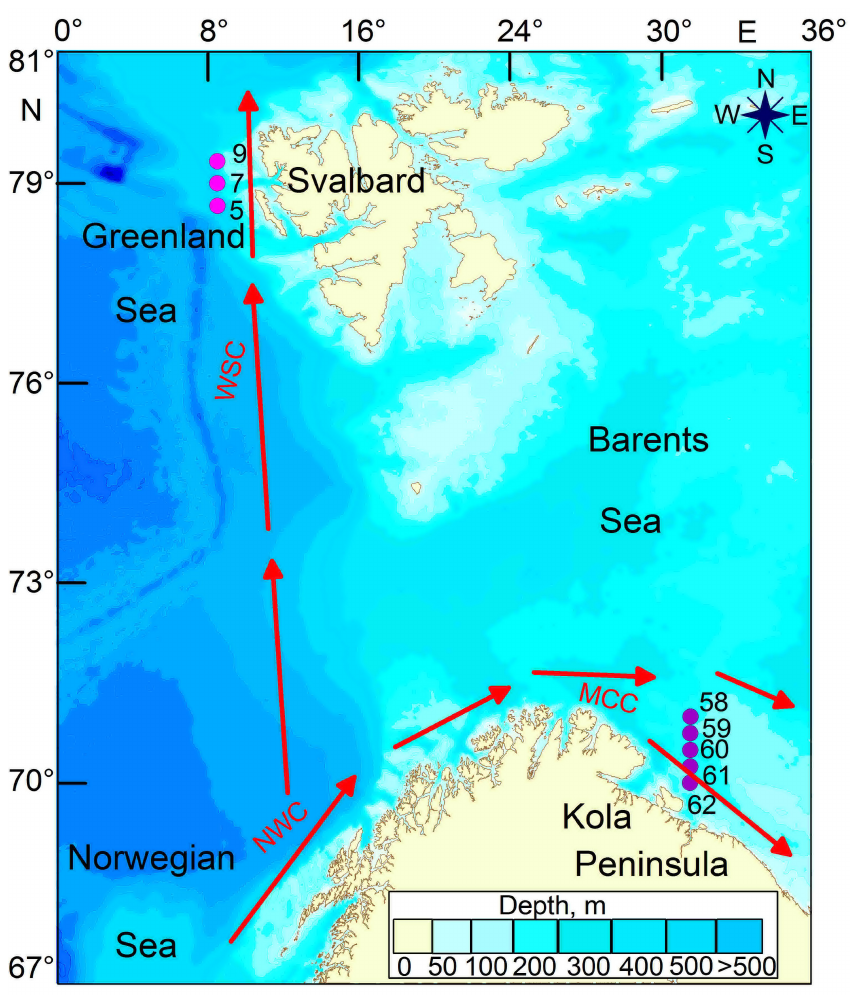
Figure 1. Map of sampling stations in the Fram Strait and in the Barents Sea, winter 2021. Red arrow denotes main Atlantic flows (WSC—West Spitsbergen Current, NWC—Norwegian Coastal Current, MCC—Murmansk Coastal